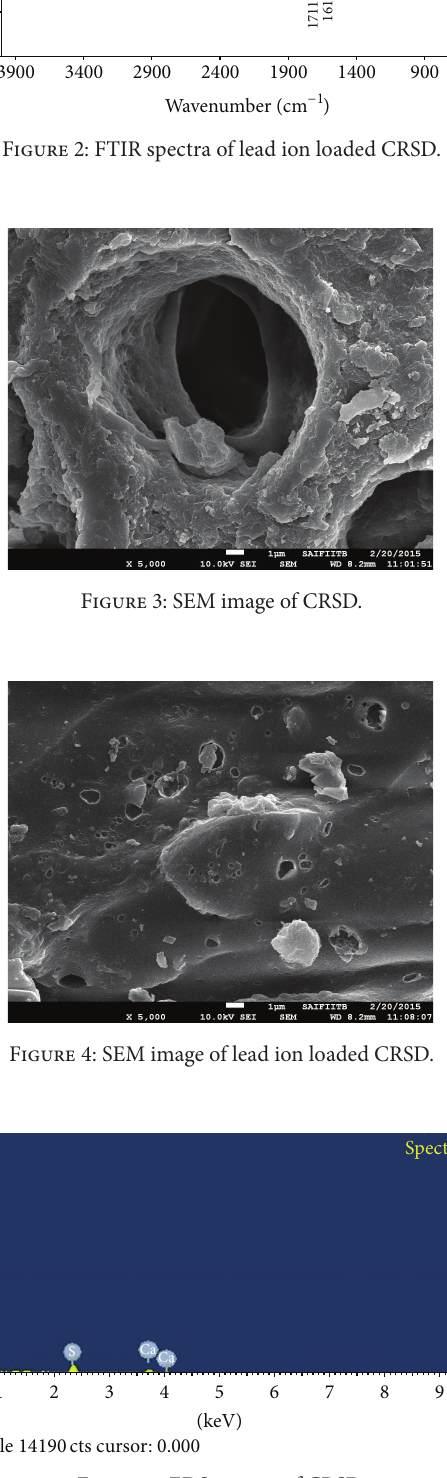
Figure 5: EDS spectra of